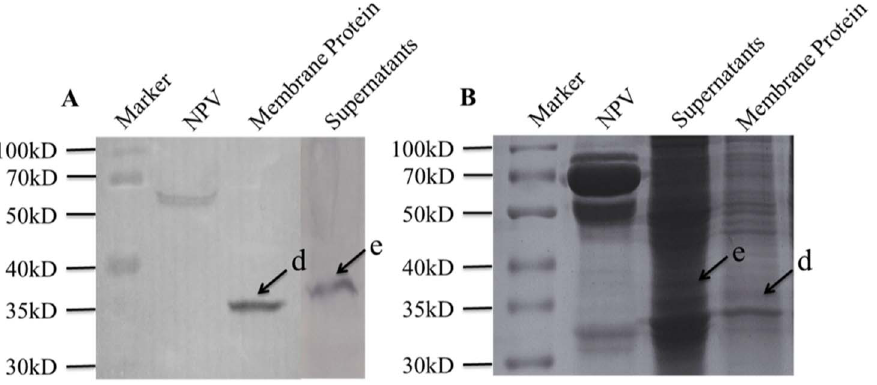
Fig. 2. Virus binding experiment on lipid-associated and hydrophilic proteins of B. mori midgut resolved by SDS-PAGE. A) Virus overlay binding experiment. B) Separation of B. mori midgut lipid- associated and hydrophilic proteins by SDS-PAGE. M indicated the standard prestained protein molecular weight marker, NPV was set as positive control, Supernatants meant hydrophilic proteins. Arrows named d, e in A) and B) referred to the detected bands on PVDF membrane and the corresponding proteins in